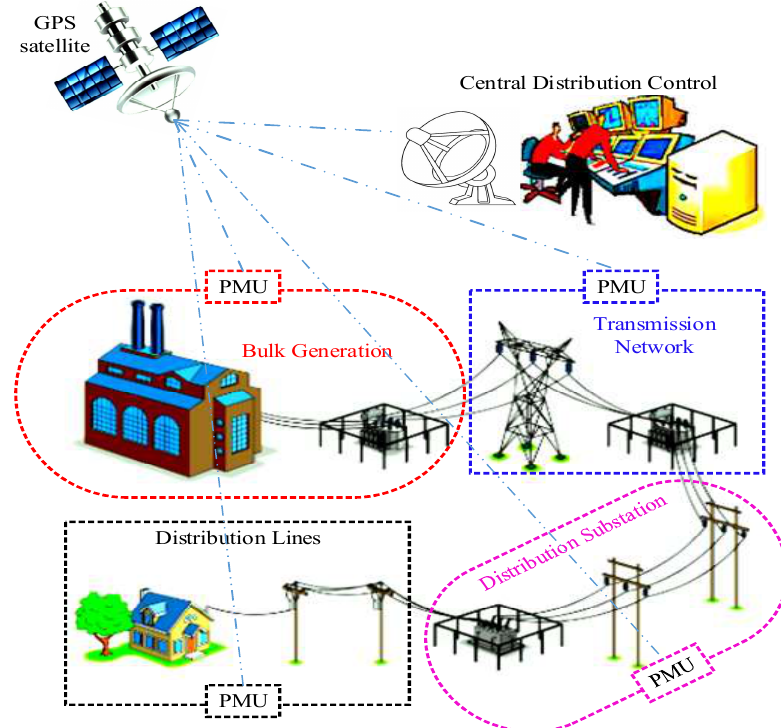
Figure 1. Power network infrastructure.